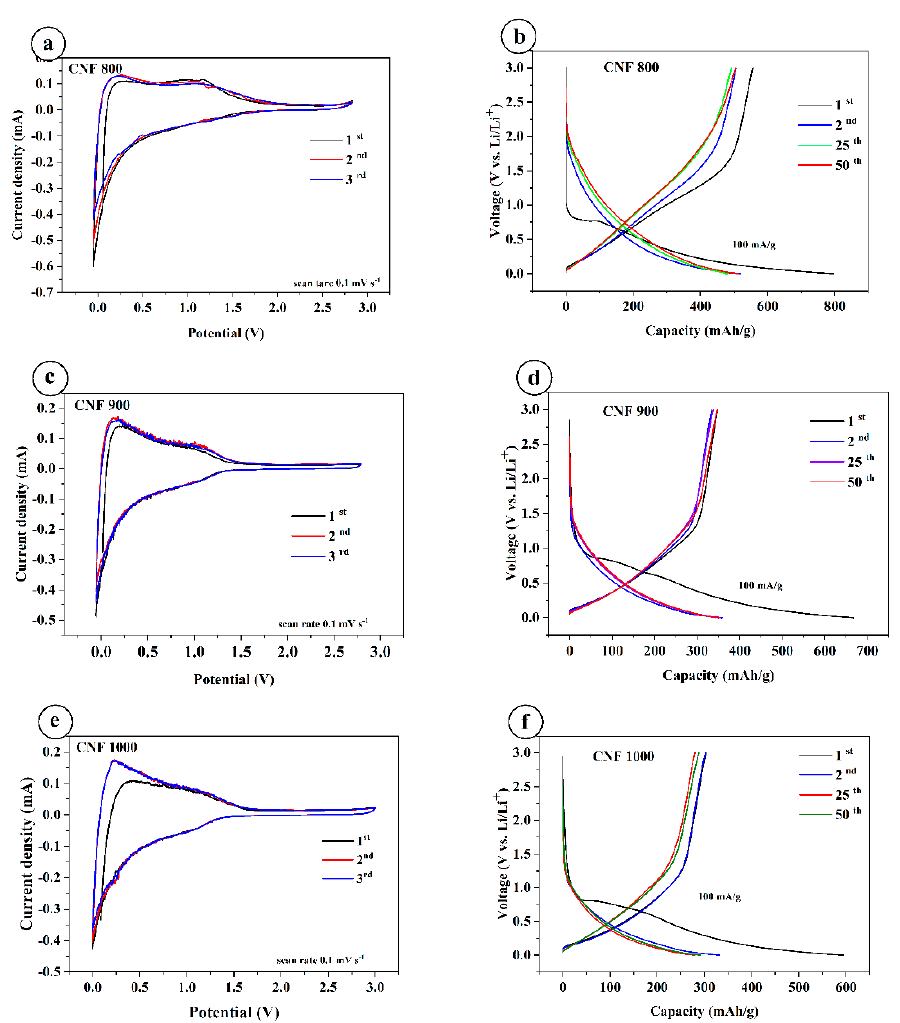
Figure 4. Cyclic voltammetry and charge–discharge curves of CNF electrodes: ( a , c , e )—cyclic voltammetry curves; ( b , d , f )—charge–discharge curves